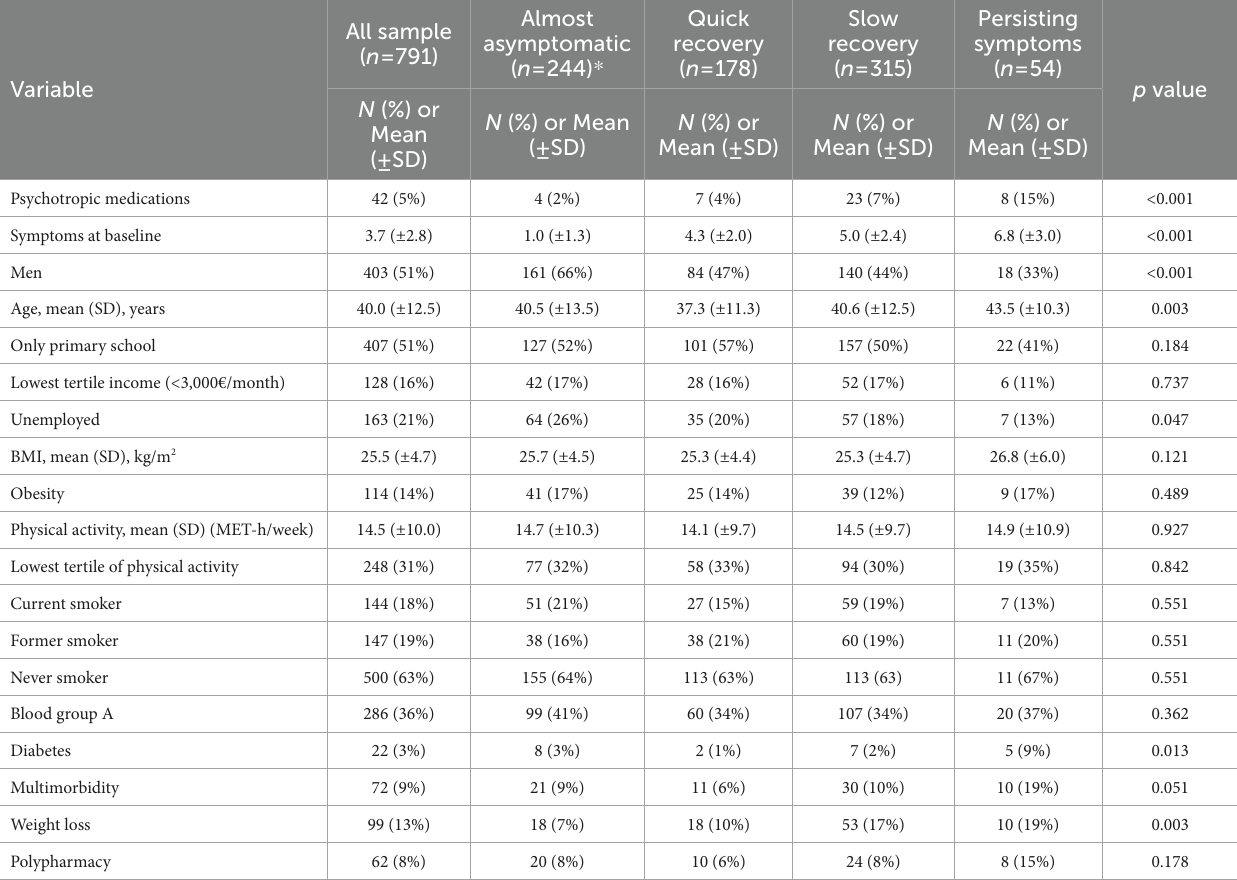
TABLE 2 Characteristic s of the population by trajectory of